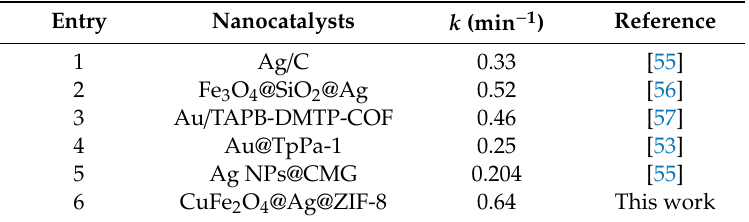
Table 1. Comparison of k of di ff erent catalytic systems for the reduction of 4-NP